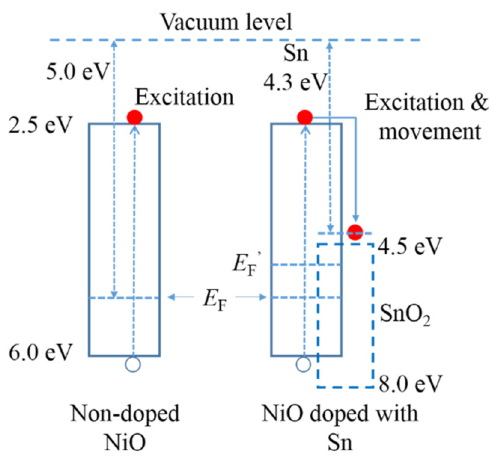
Figure 7. Energy band diagram showing the effect of Sn doping into NiO.